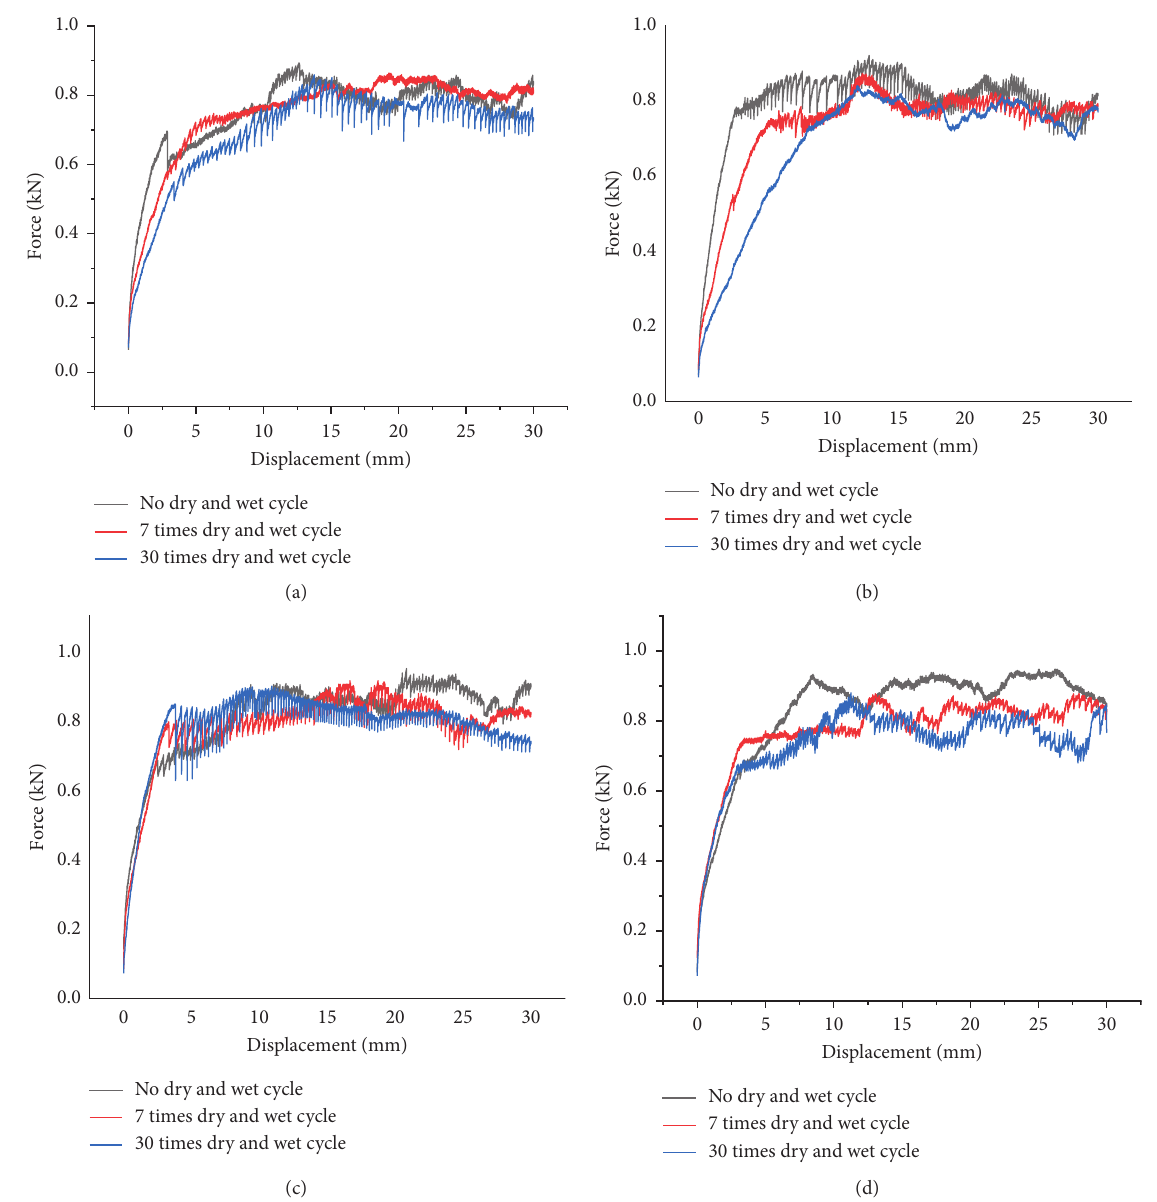
Figure 8: The pullout force-displacement curve with different water content for dry-wet cycles under the overburden pressure of 5kPa. (a) 4%. (b) 8%. (c) 14%. (d)